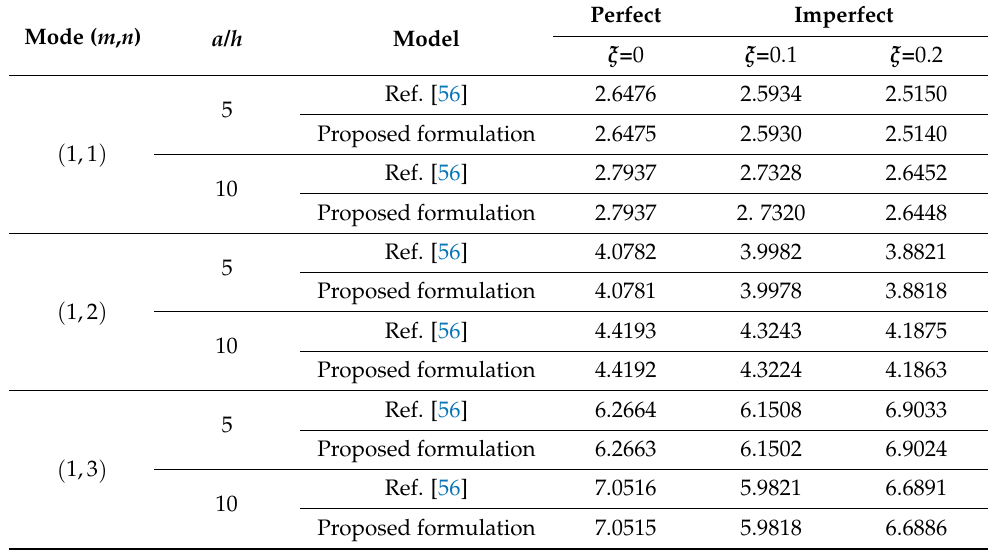
Table 4. Comparison of natural frequencies ω for a rectangular plate with Al/Al 2 O 3 and p = 1. Mode ( m , n ) a / h Model